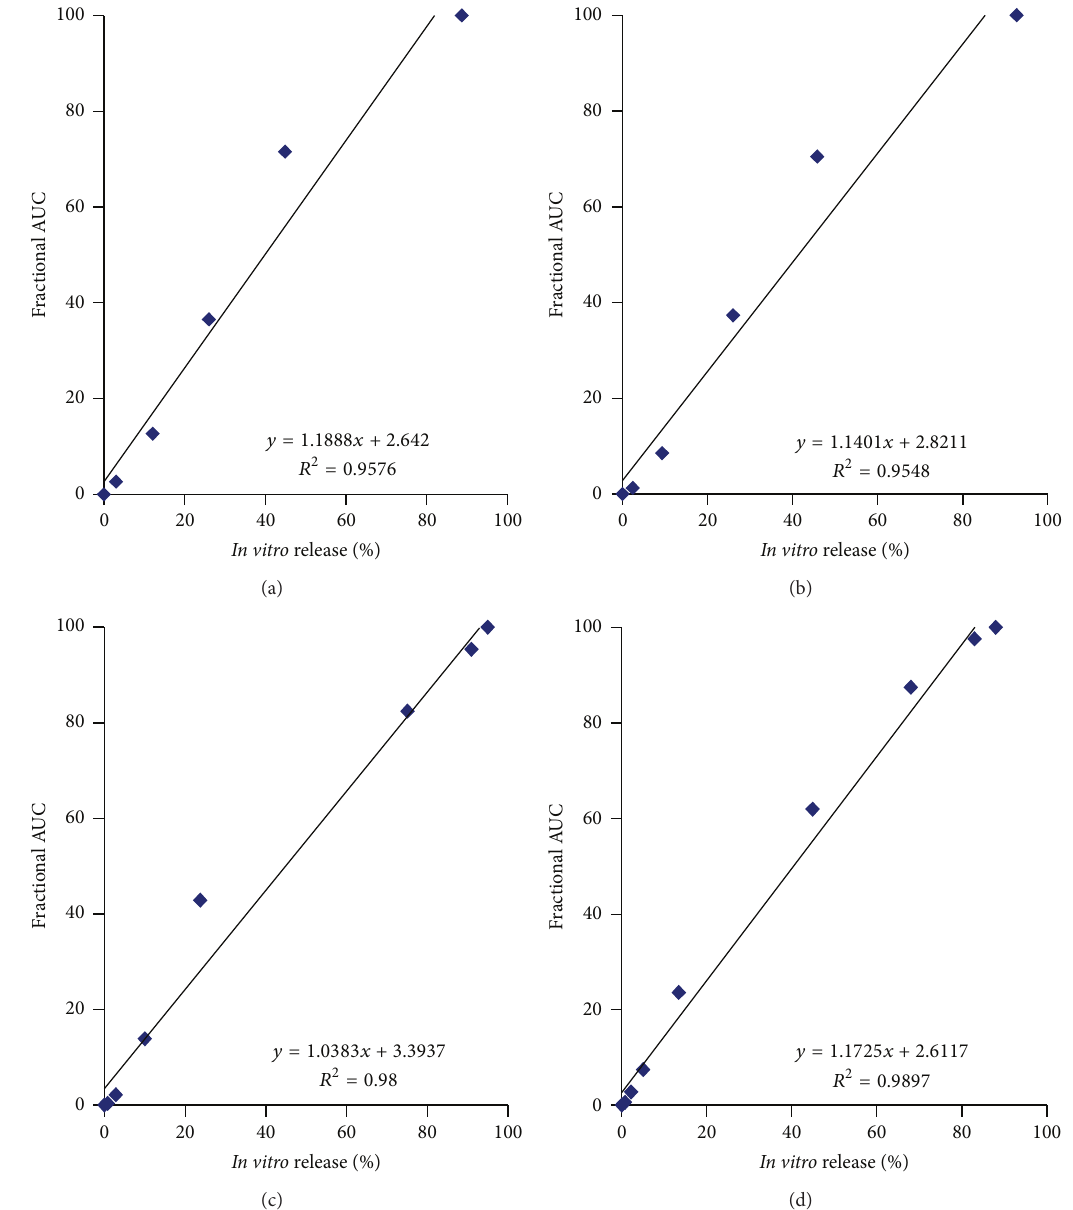
Figure 8: Level A IVIVC for Olanzapine PLGA microspheres using fractional